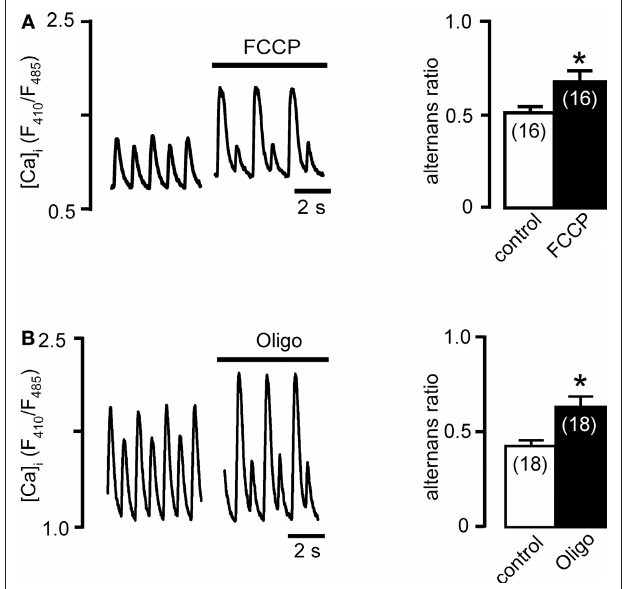
Figure 1 | effects of mitochondrial membrane potential and ATP production on Ca alternans. (A) Left: Ca transients recorded before and after treatment with FCCP (0.1 μM) to collapse the mitochondrial membrane potential ( ∆Ψ ). Right: average AR in control conditions and in the presence of FCCP. (B) m Effect of inhibition of mitochondrial F / F -ATP synthase with oligomycin (Oligo, 1 0 1 μg/ml) on Ca alternans. Numbers in parentheses indicate the number of individual cells tested. *significantly different from control at P <